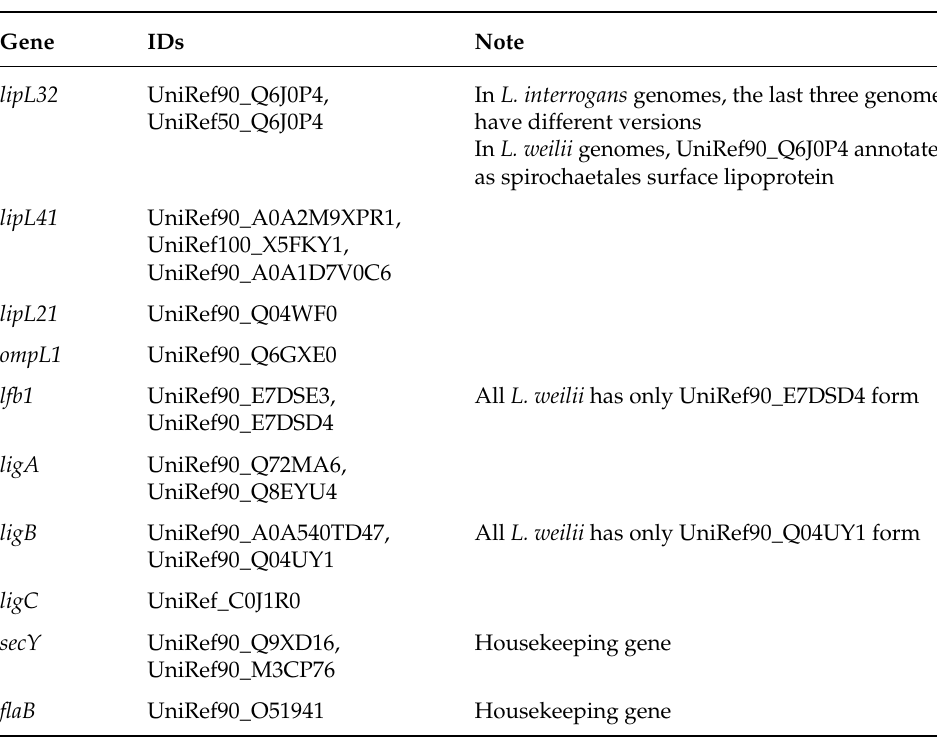
Table 1. Detection of Leptospira virulence factor genes by Bakta version